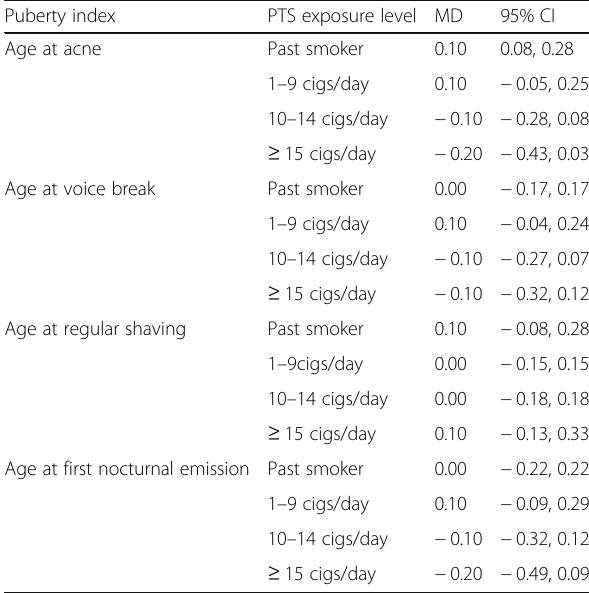
Table 3 Mean difference (MD) and 95%CI of age at four puberty index of boys with different PTS exposure levels in Håkonsen 2013